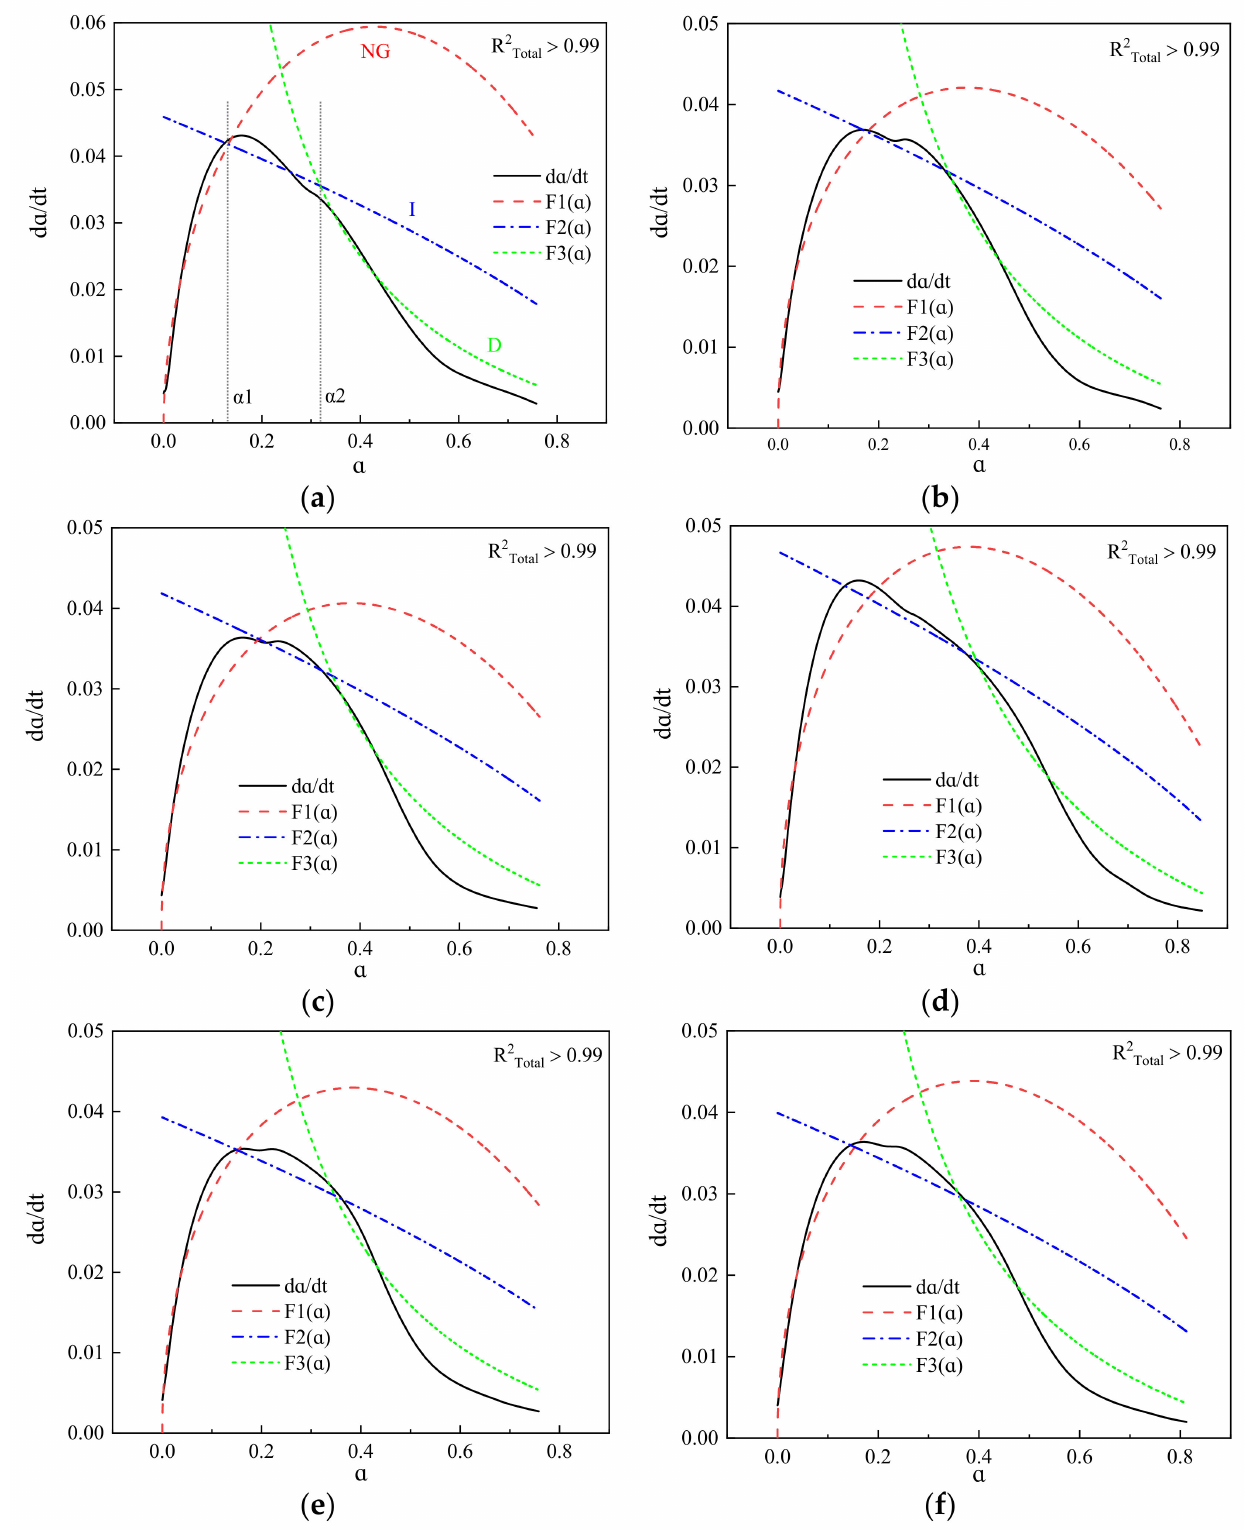
Figure 9. Fitting curve of composite cementing material reaction rate. ( a ) Cement, ( b ) 0.9Cement+0.1GFS-III, ( c ) 0.7Cement+0.3GFS-III, ( d ) 0.5Cement+0.5GFS-III, ( e ) 0.5Cement+0.5GFS-II, ( f )